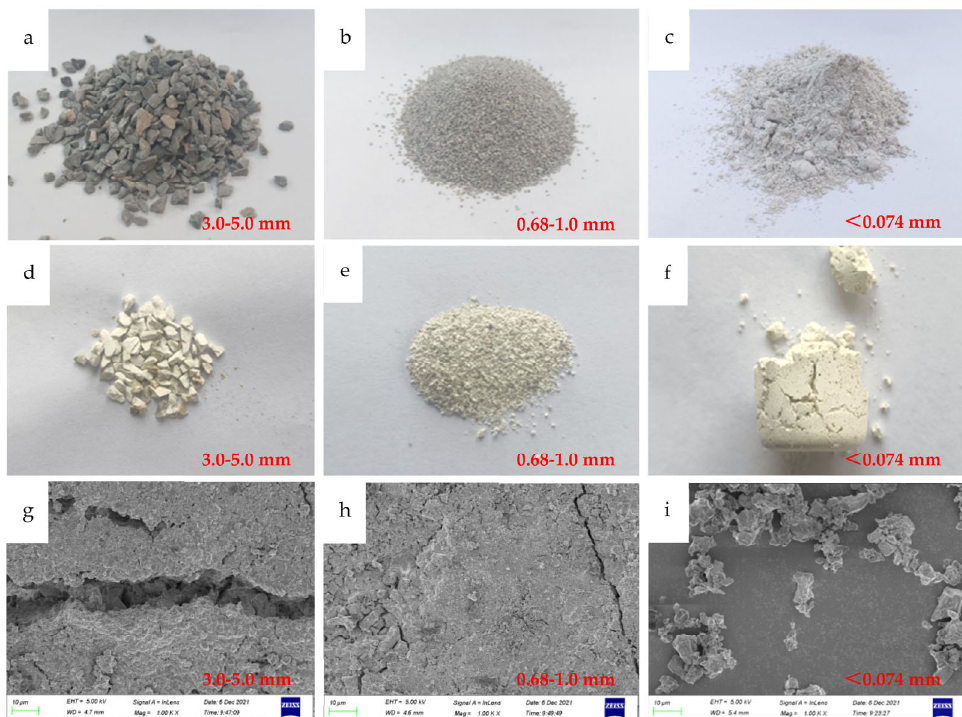
Figure 6. Comparison of limestone before and after calcination. Comparison of limestone before and after calcination. Original morphology of limestone particles before calcination for ( a – c ). Macroscopic morphology of limestone particles after calcination for ( d – f ). Microscopic morphology of the surface of limestone particles after calcination for ( g – i ).